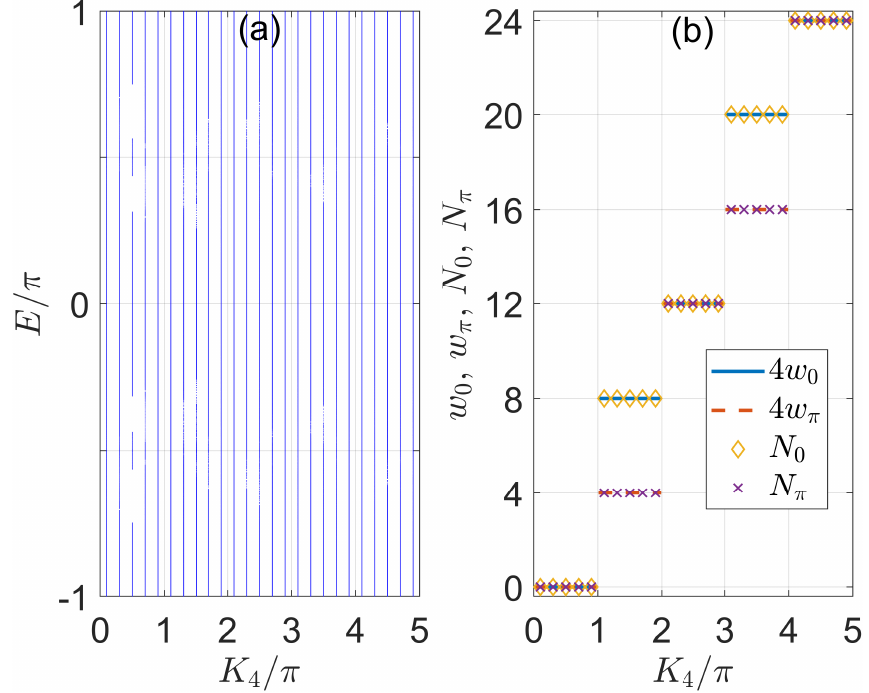
Figure 4. Floquet spectrum E in panel ( a ) and number of corner modes ( N 0 , N π ) in panel b of the 2D on-resonance double − kicked lattice versus the kicking strength K 4 . The other system parameters are set as ( K 1 , K 2 , K 3 ) = ( 0.5 π ,3.5 π ,0.5 π ) . The size of the lattice is L x = L y = 300. In panel ( b ), N 0 and N π are plotted together with the bulk topological invariants w 0 and w π as obtained from Equations (33) and